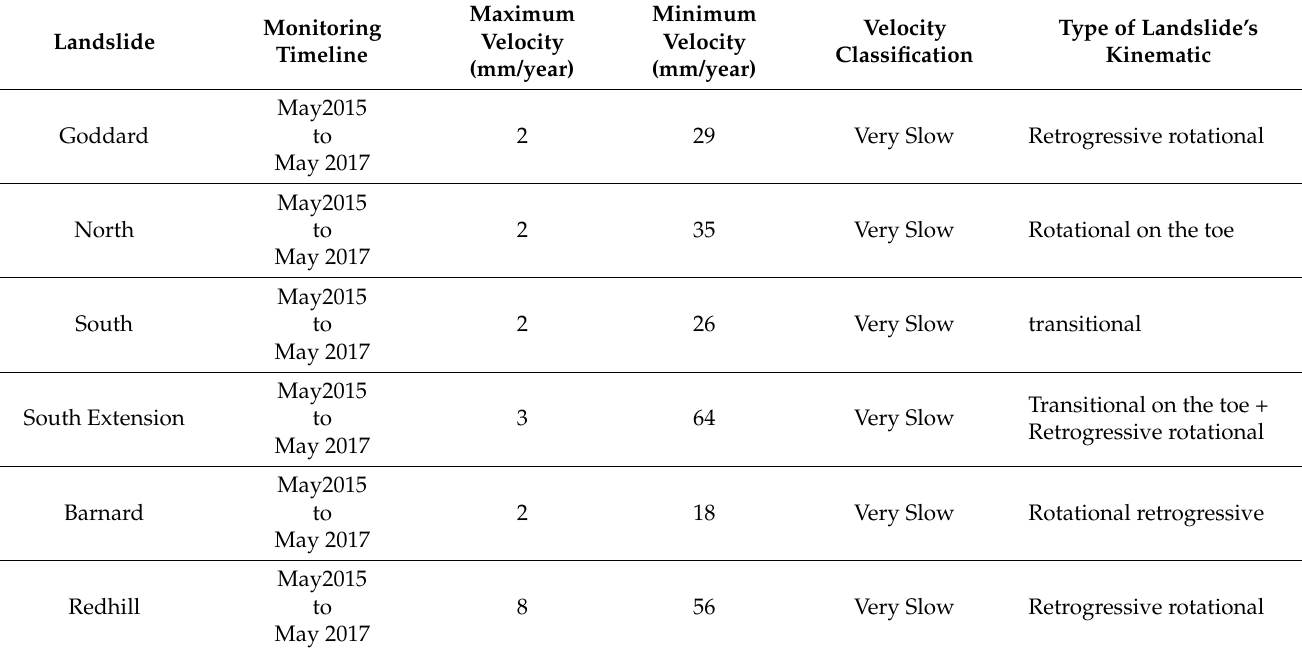
Table 9. Summary of all monitored landslides along the Thompson River